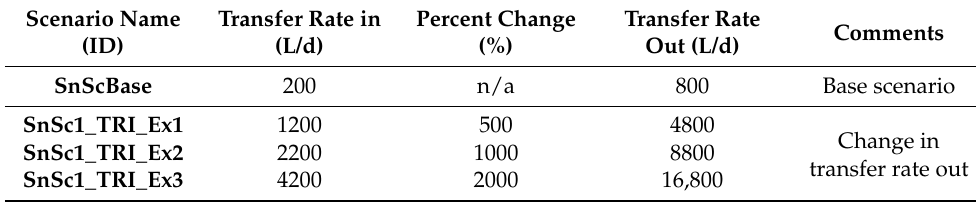
Table 4. Model scenario with high change in material property (transfer rate in and